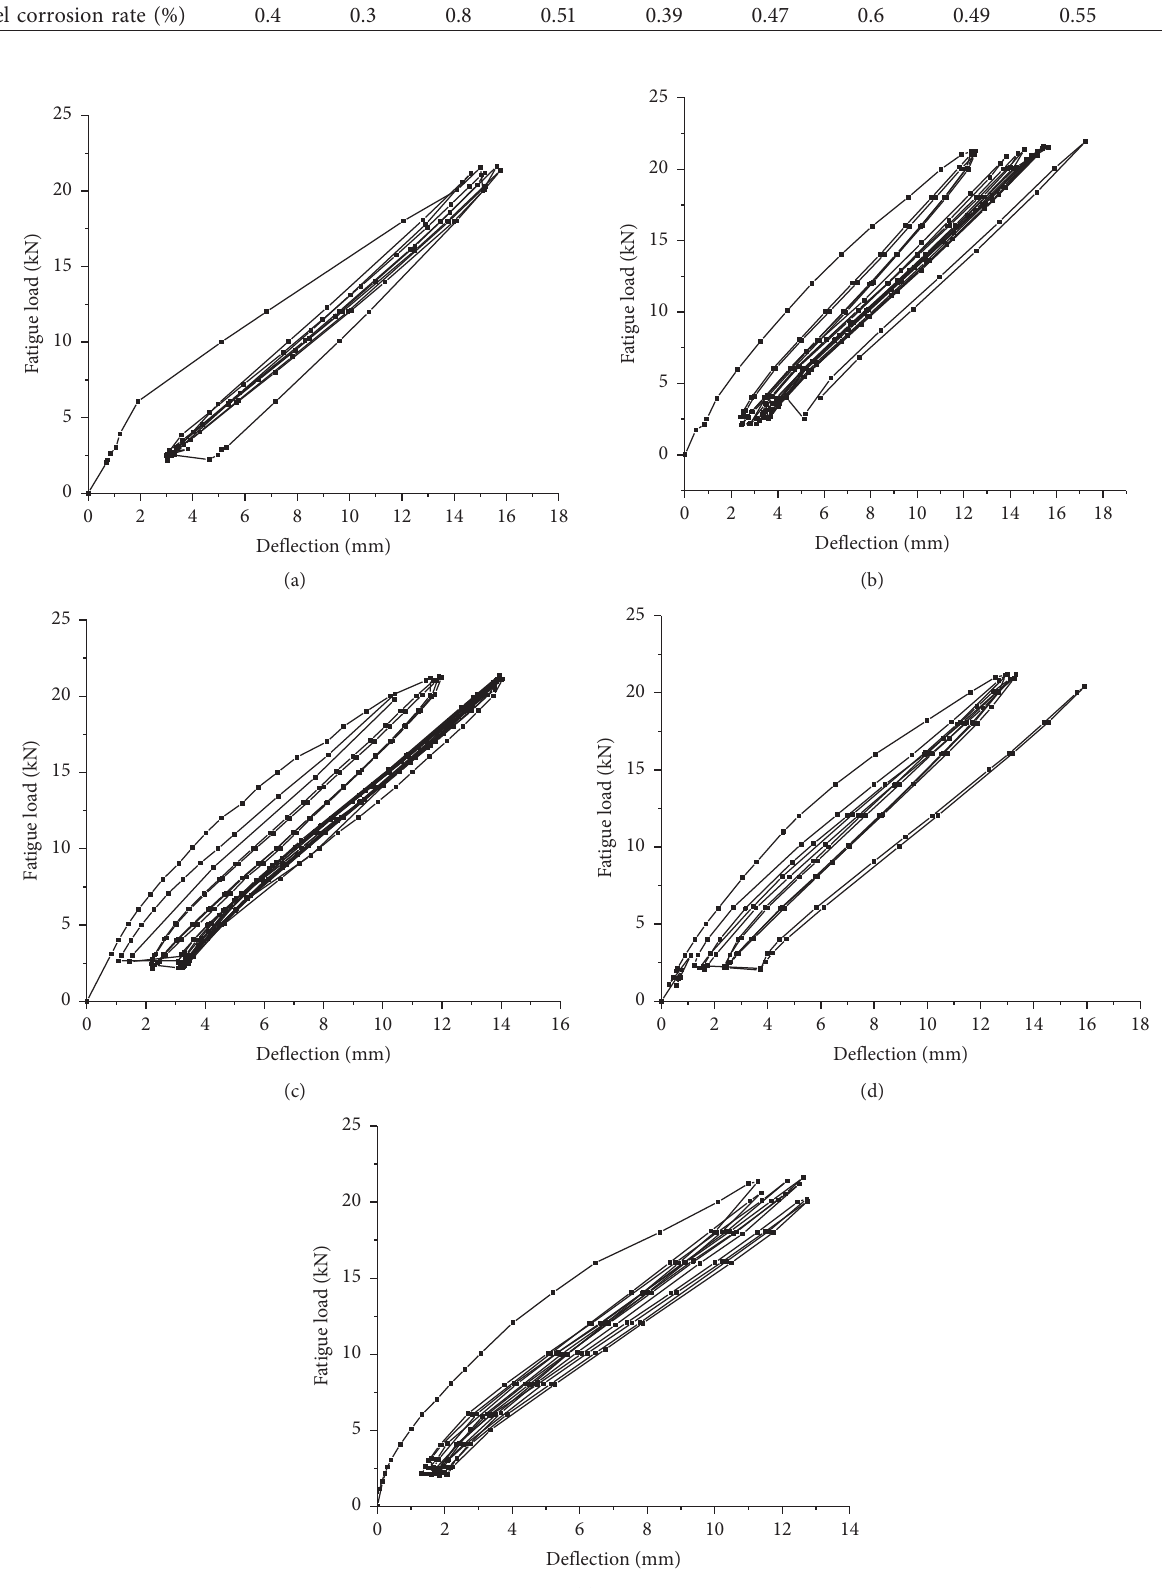
Figure 9: Load-deflection curve of each beam. (a) Beam 2. (b) Beam 3. (c) Beam 4. (d) Beam 5. (e) Beam 6.